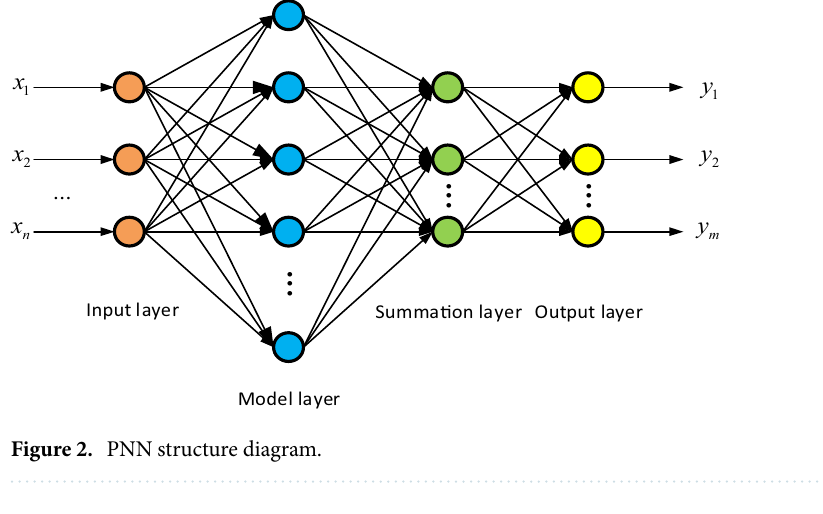
Figure 2. PNN structure diagram.